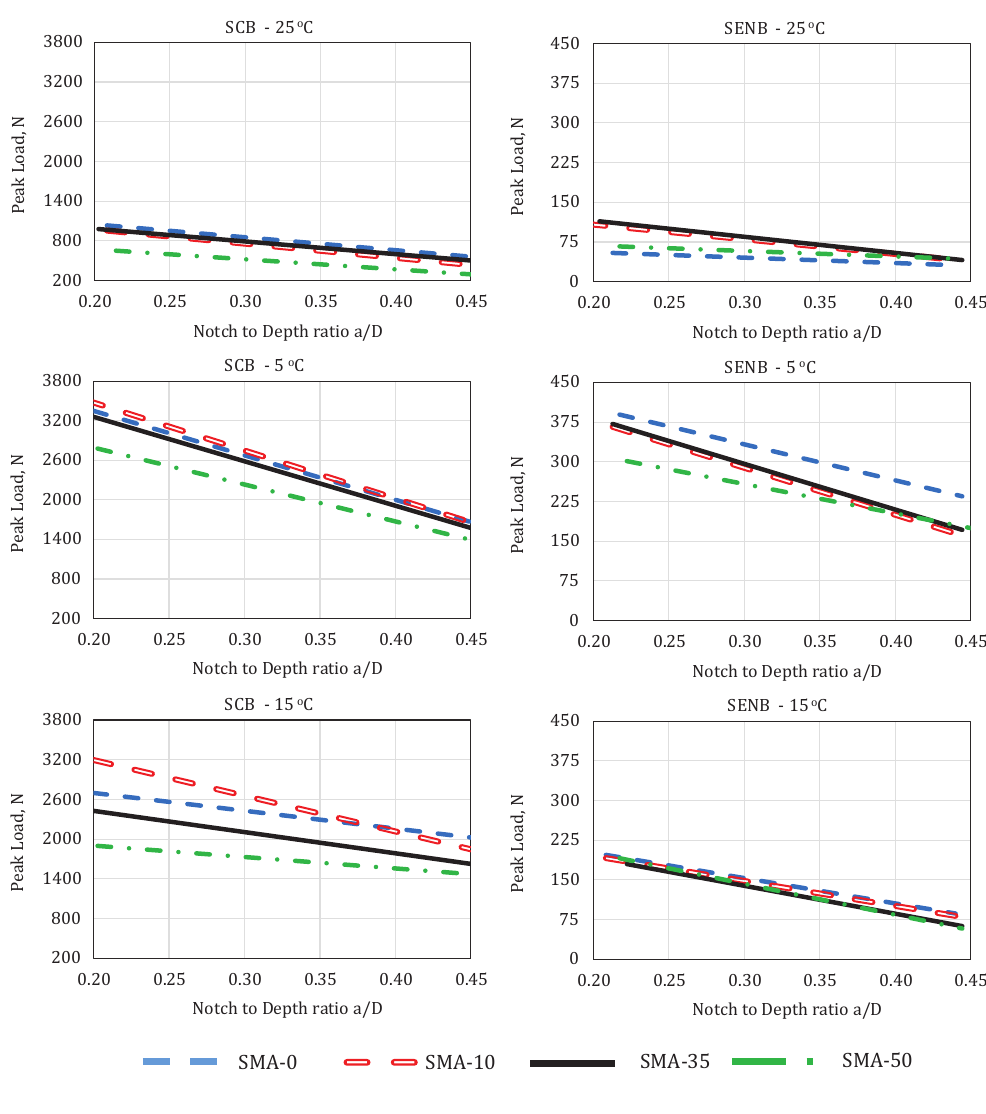
Figure 9. Peak load vs. notch depths at varying